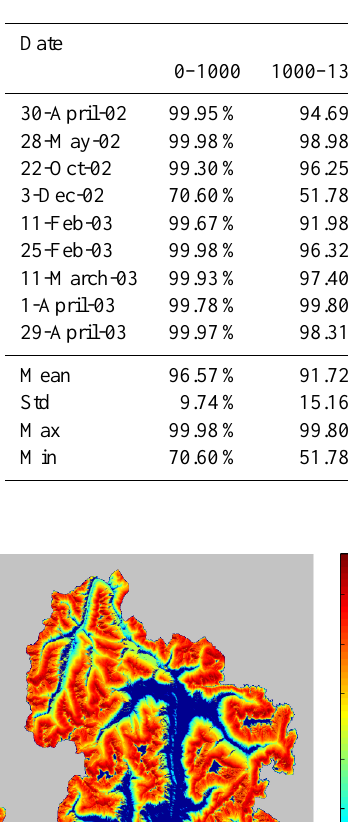
Table 12. Overall accuracy for 6 elevation ranges.